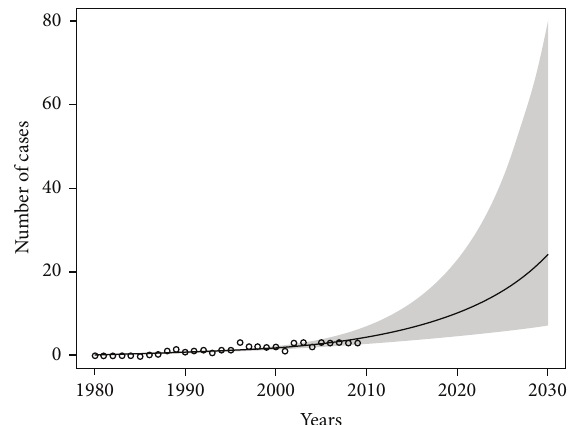
Figure 4: The forecast of increasing incidence of asbestos-related lung cancer in the zone number III until 2030. Significance level of model: 𝑃 < 0.01